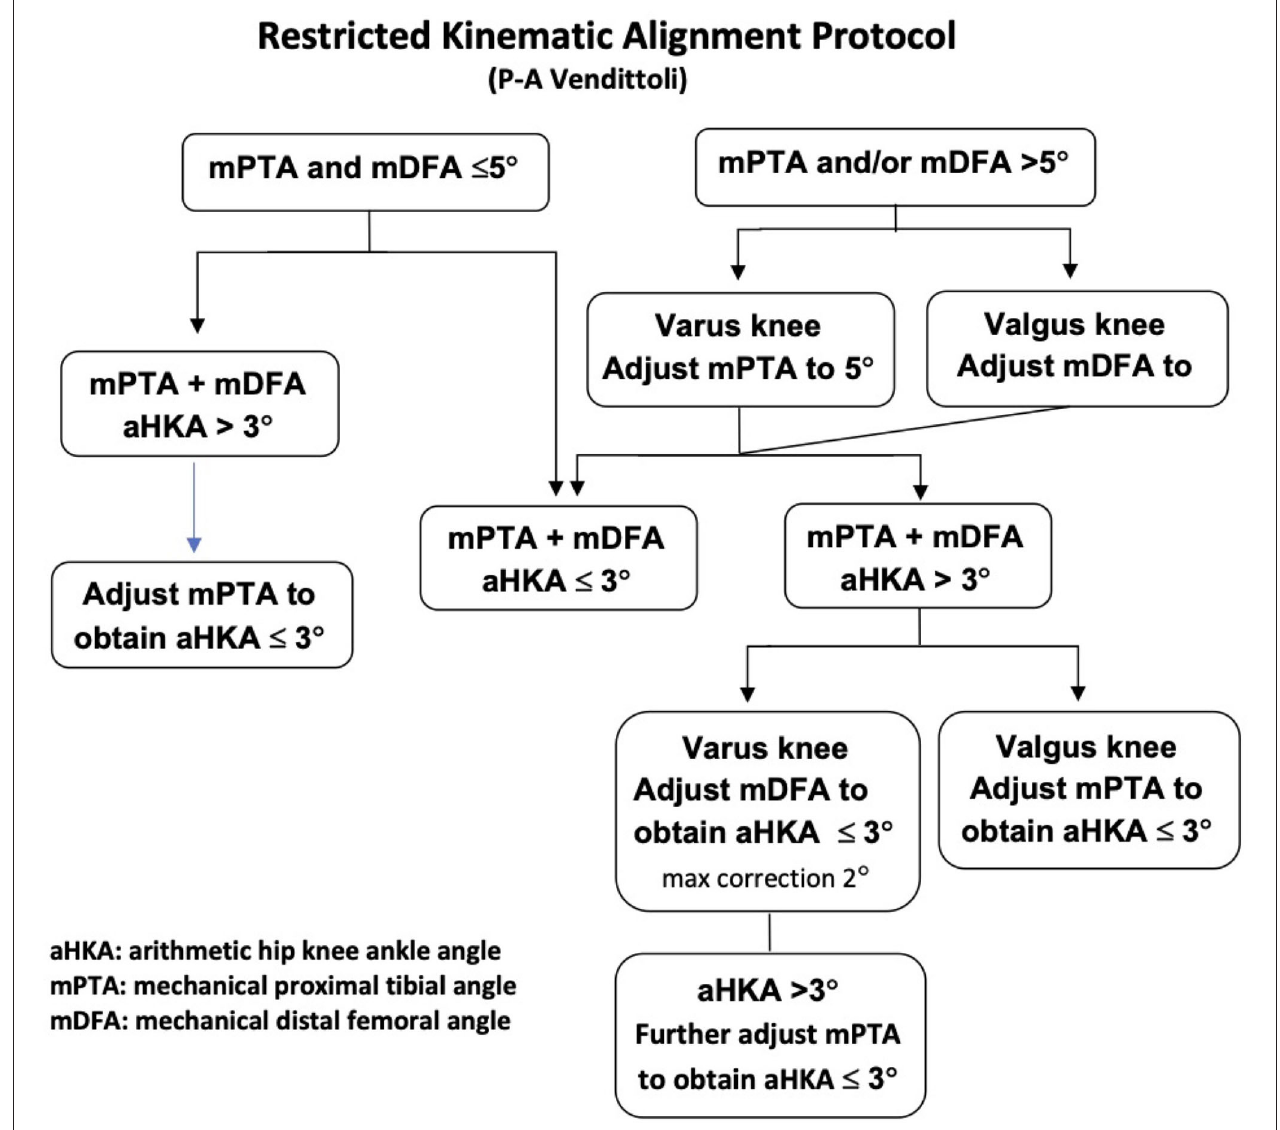
FIGURE 1 | Vendittoli’s restricted kinematic alignment